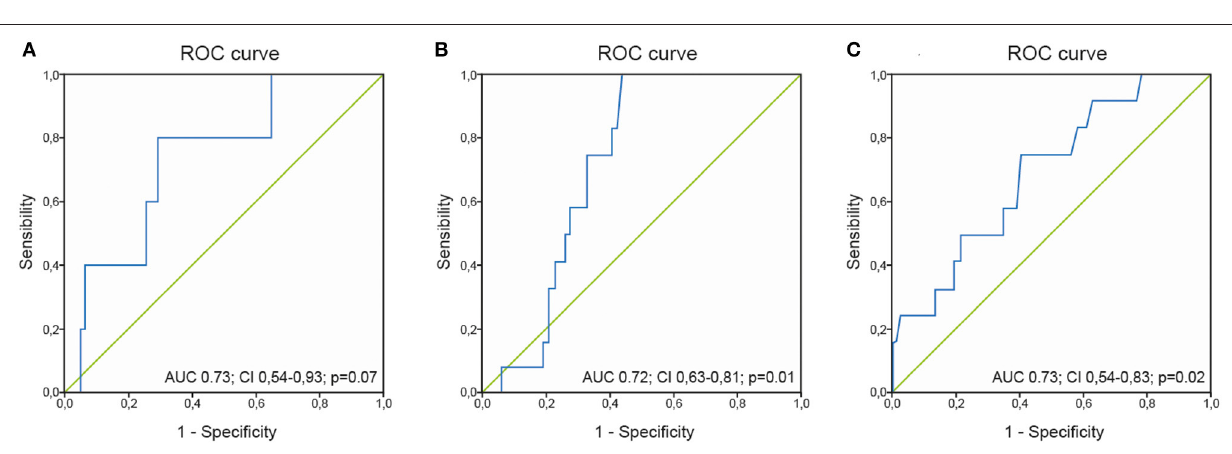
FIGURE 2 | ROC curve for lactate levels at admission and biliary complications (A) or mortality (B) , and ROC curve for lactate levels at 6h and mortality (C)